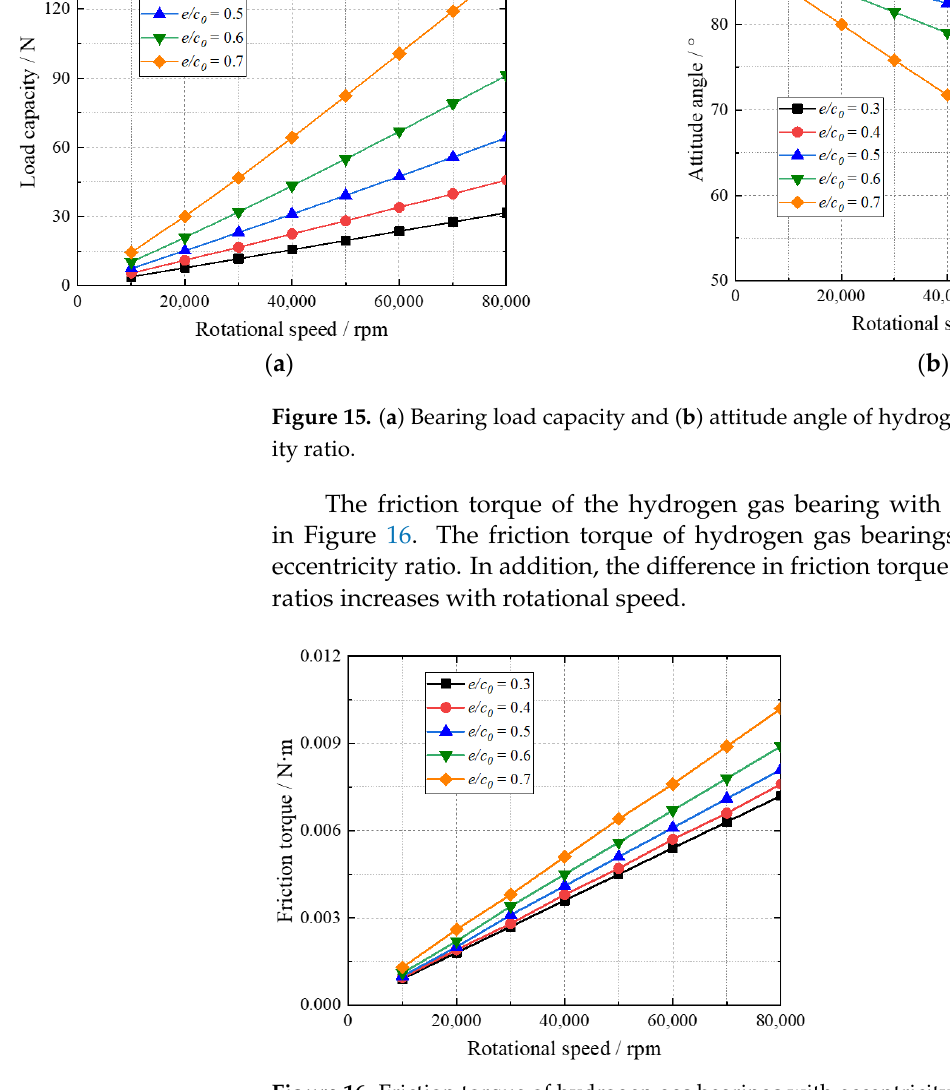
Figure 16. Friction torque of hydrogen gas bearings with eccentricity